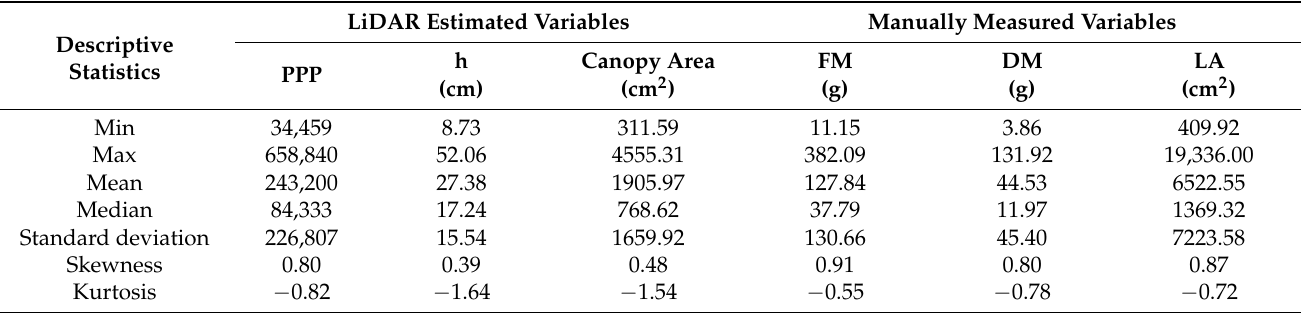
Table 2. Descriptive statistics of LiDAR-estimated parameters (points per plant (PPP), height (h), and ground projected canopy area (canopy area)) and manually measured variables (fresh mass (FM), dry mass (DM), and leaf area (LA)) of strawberry canopies capturing four size classes ( n = 15).